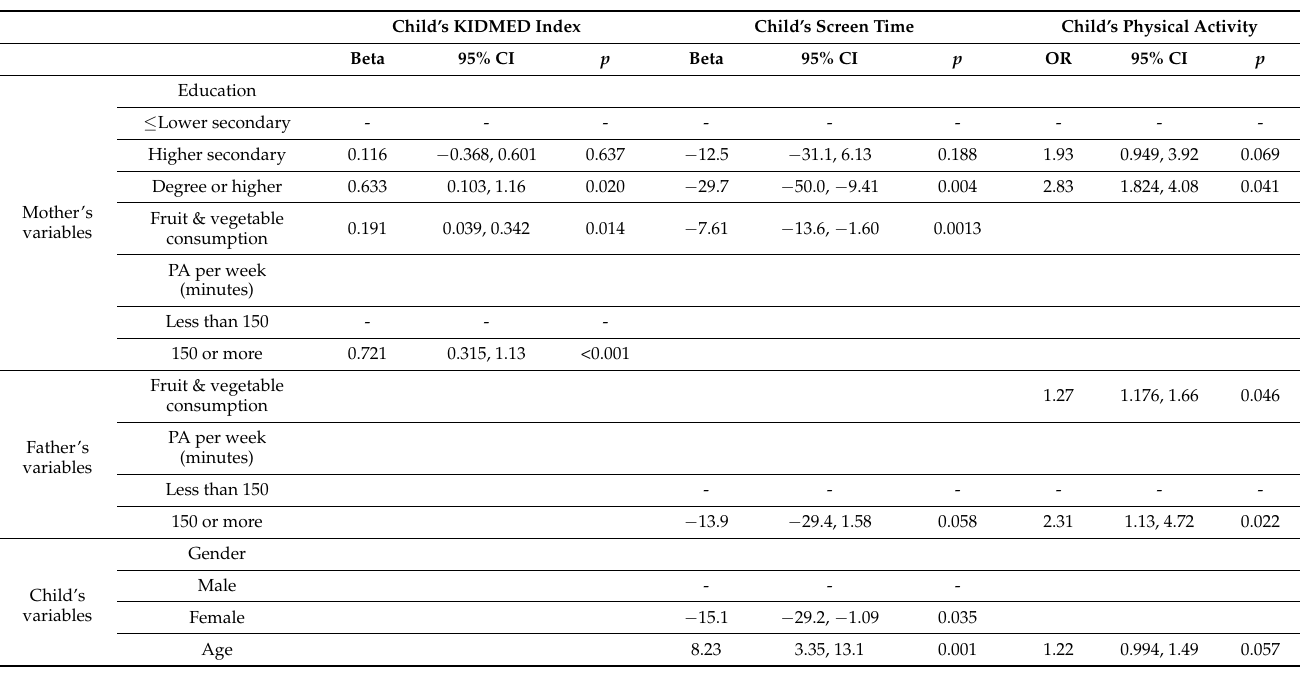
Table 2. Regression models